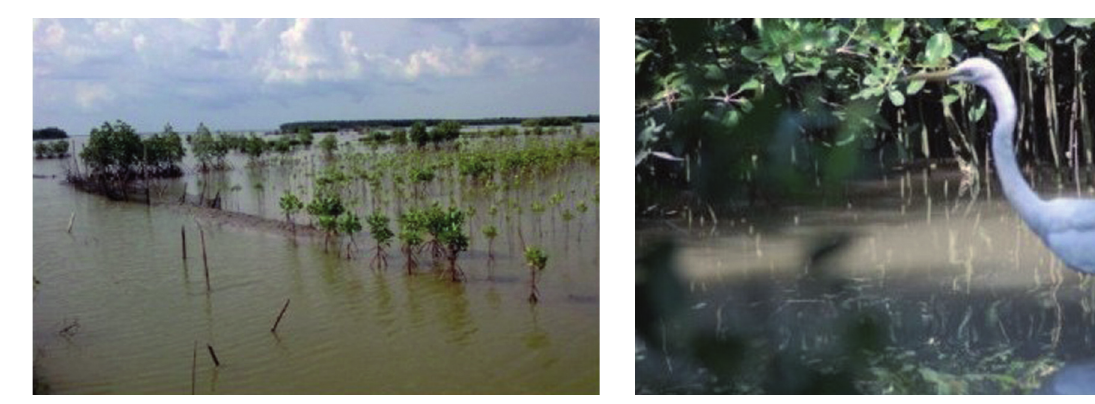
Fig. 6. Mangrove planted by local community of Tambak- sari.